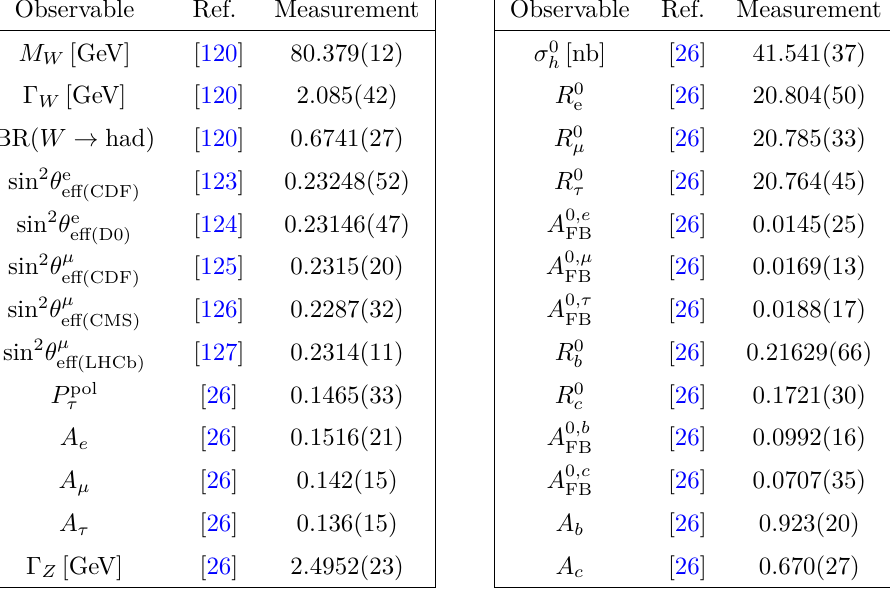
Table 3 . EW observables included in our global fit together with their current experimental values.